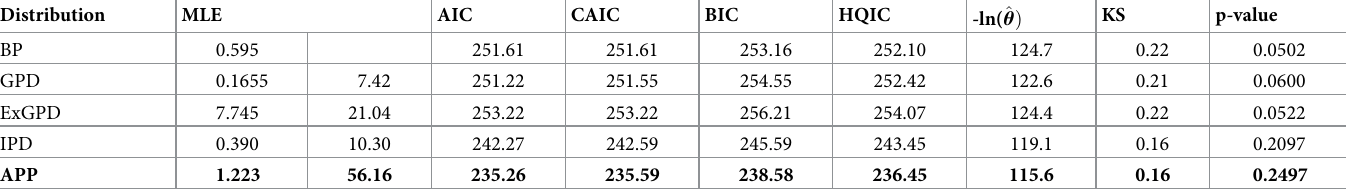
Table 3. Goodness of fit result for data set